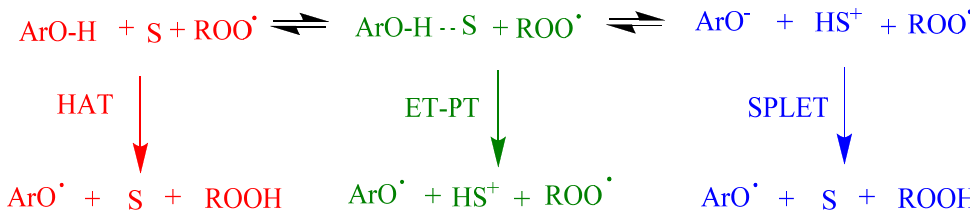
Figure 4. Proposed mechanisms between antioxidants (ArOH) and peroxyl radicals (ROO • ) comprising the hydrogen atom transfer (HAT), electron transfer–proton transfer (ET-PT) and single-proton-loss electron-transfer (SPLET). S = Solvent. Adapted from reference [6].